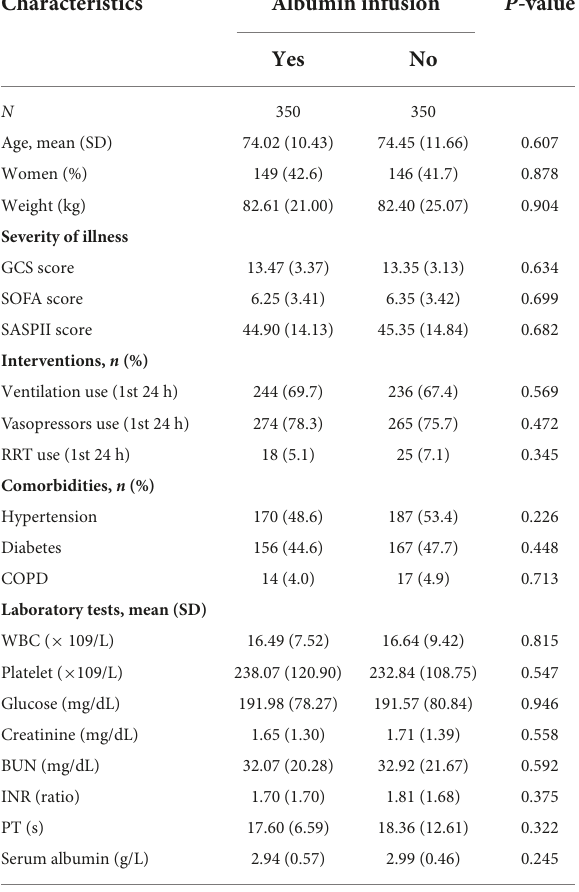
TABLE 1 Comparisons of baseline characteristics for patients with albumin infusion or not.